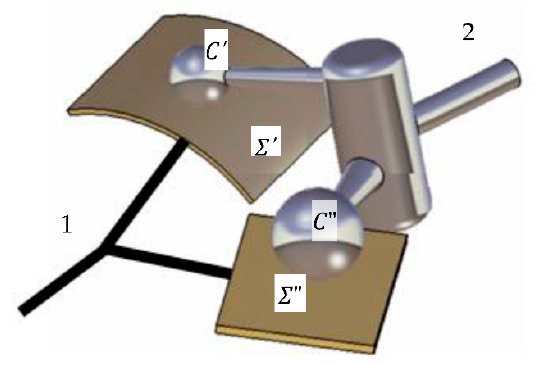
Figure 5. The revolute joint between the elements 1 and 2.